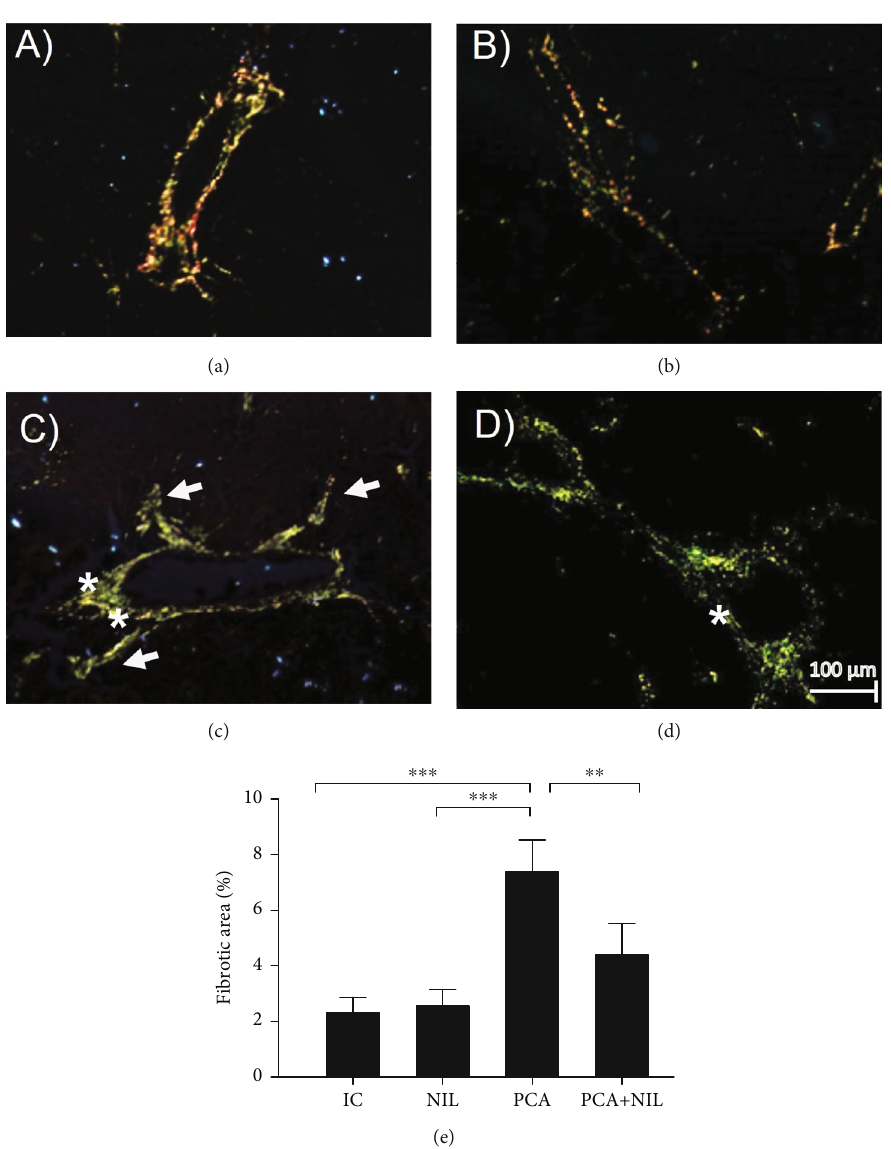
Figure 9: Liver slides stained with Sirius Red analyzed under polarized light to assess the area of fi brosis. (a) Periportal area from an IC animal. Normal distribution of type III collagen (mainly green color) is observed. (b) NIL liver slide. Similar distribution of collagens of the IC group is apparent. (c) PCA liver slide. Increase in collagen type I (red) and III (yellow) distribution is observed in the periportal area, with thickening of the triad vessels. Also, an increased collagen invasion into the surrounding liver parenchyma ( ∗ ) is apparent. (d) PCA+NIL. It shows regression of type I collagen, mainly in the periportal area ( ∗ ). (e) Comparisons of percentage of the fi brosis areas in the several experimental groups. Observe that between the IC and NIL groups, similar percentages of fi brosis are apparent. In contrast, the PCA animals developed a signi fi cant increase in the fi brotic area ( ∗∗ p < 0 : 001 : IC vs. PCA). In the PCA+NIL group, the percentage of fi brosis was signi fi cantly decreased as compared with the PCA group ( ∗ p < 0 : 01 : PCA vs. PCA+NIL group), indicating reversible e ff ect of AVP de fi ciency on liver fi brosis. It was evaluated with analysis of variance test with the Tukey post hoc values, which are expressed as the mean ± SD . Pictures are taken at 20x magni fi